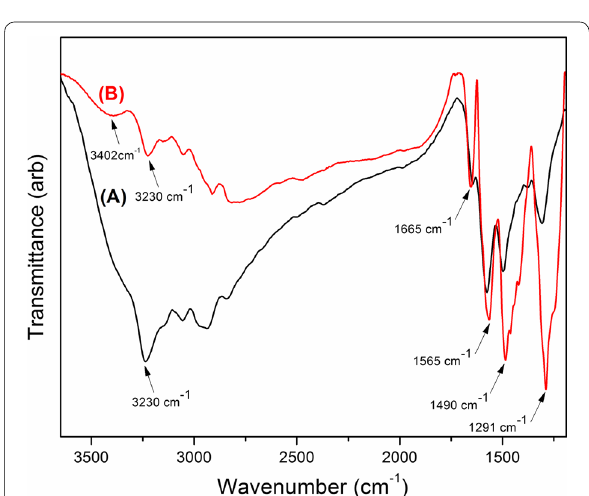
Fig. 4 FT-IR spectra of PAni film (A) before drying process and (B) after drying process